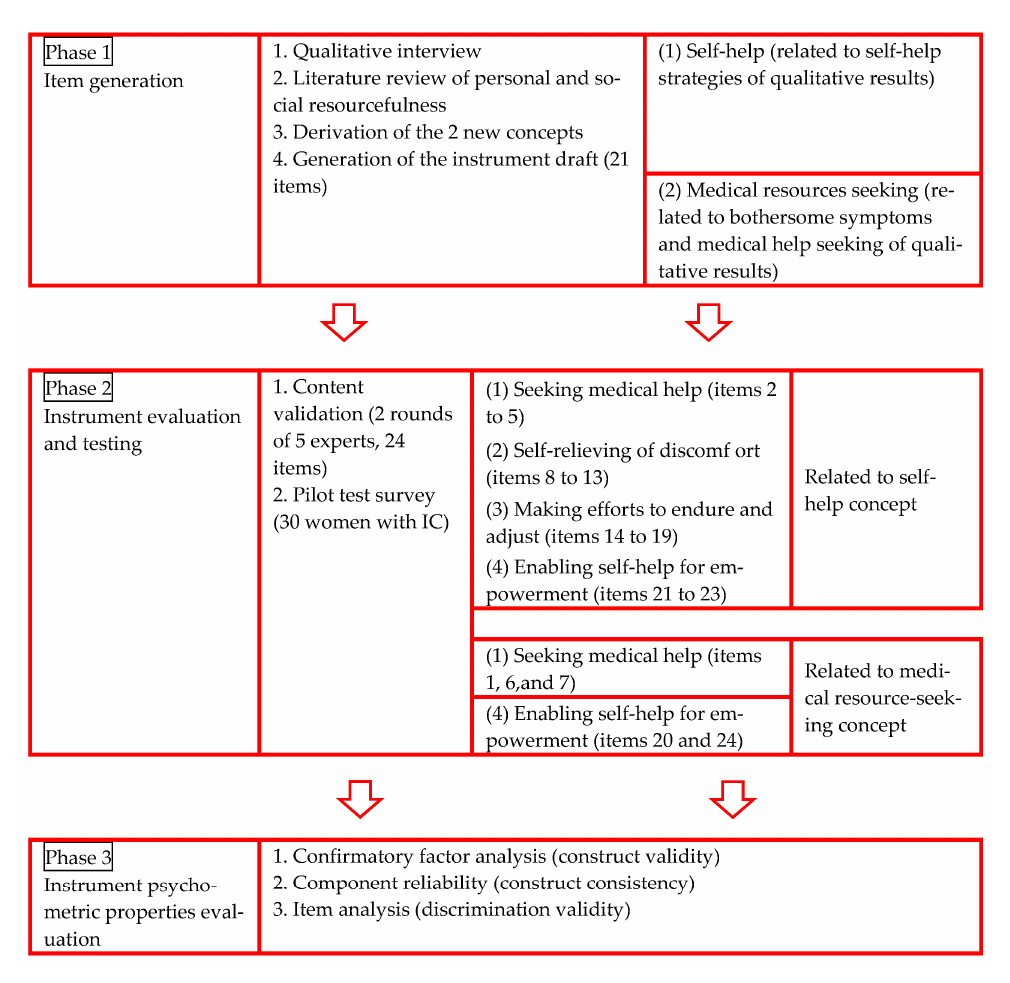
Figure 1. Flow chart of the development of the ICSR.